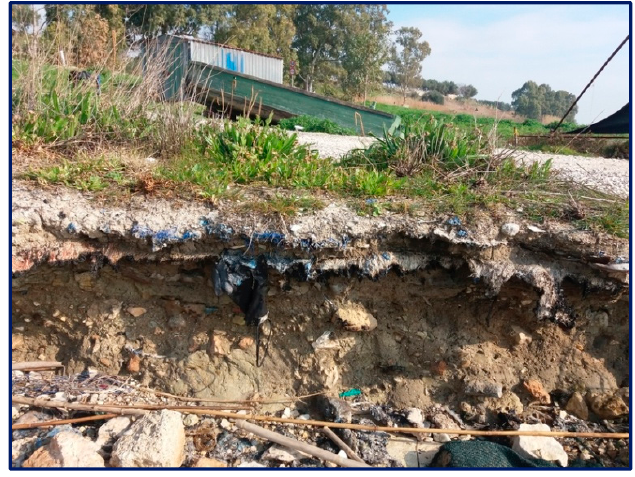
Figure 2. Layering of plastic materials in an area of Southern Italy.